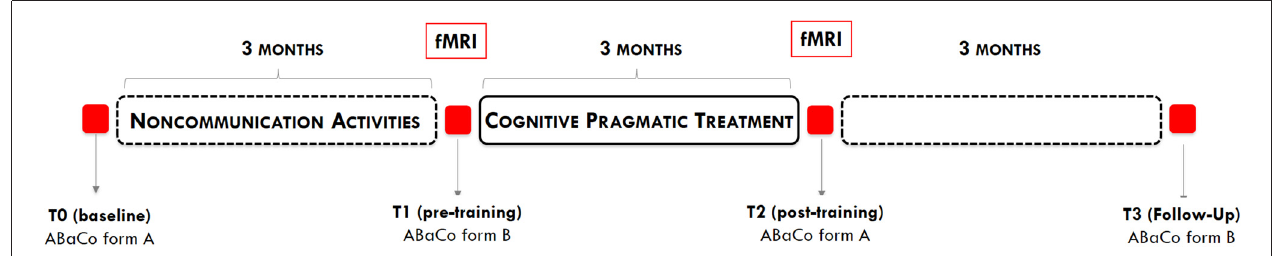
FIGURE 1 | Graphical representation of the experimental design .